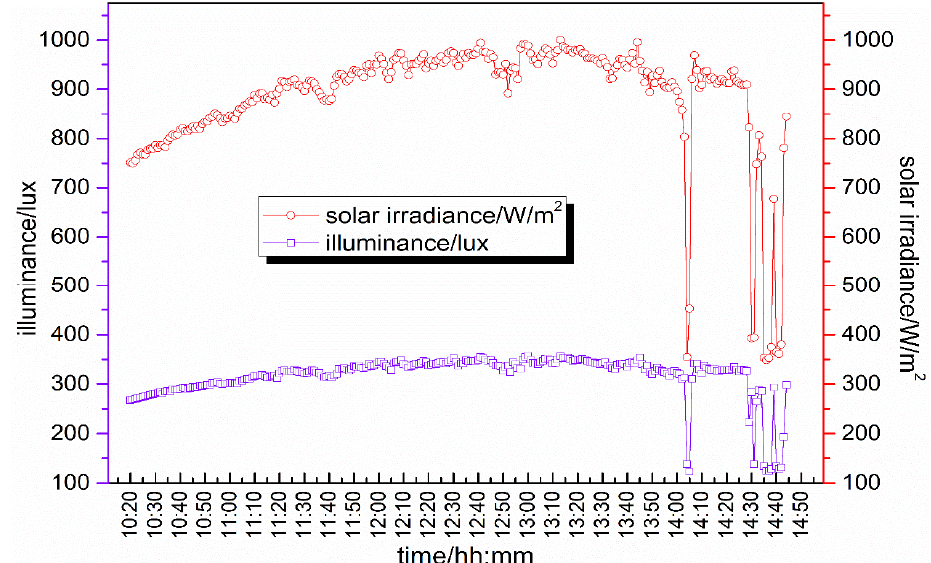
Figure 15. A diagram of the system’s output illuminance compared to solar radiation intensity (high intensity).